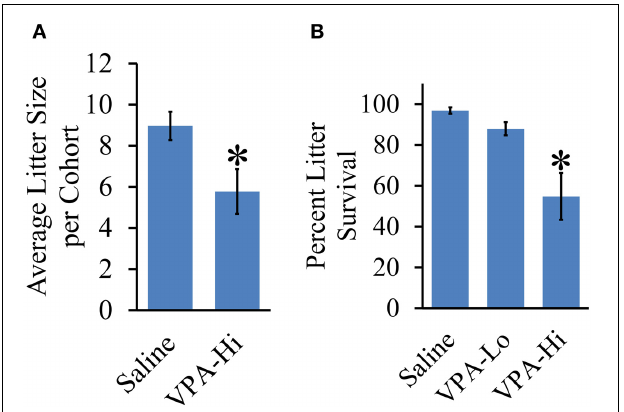
FIGURE 6 | Progeny from VPA-Hi exposed dams exhibit reduced social interaction. (A) VPA-Hi animals spent less time in the social interaction zone compared to saline animals (saline = 15, VPA-Hi = 15). (B) Latency to first entry into the social interaction zone was higher in VPA-Hi animals compared